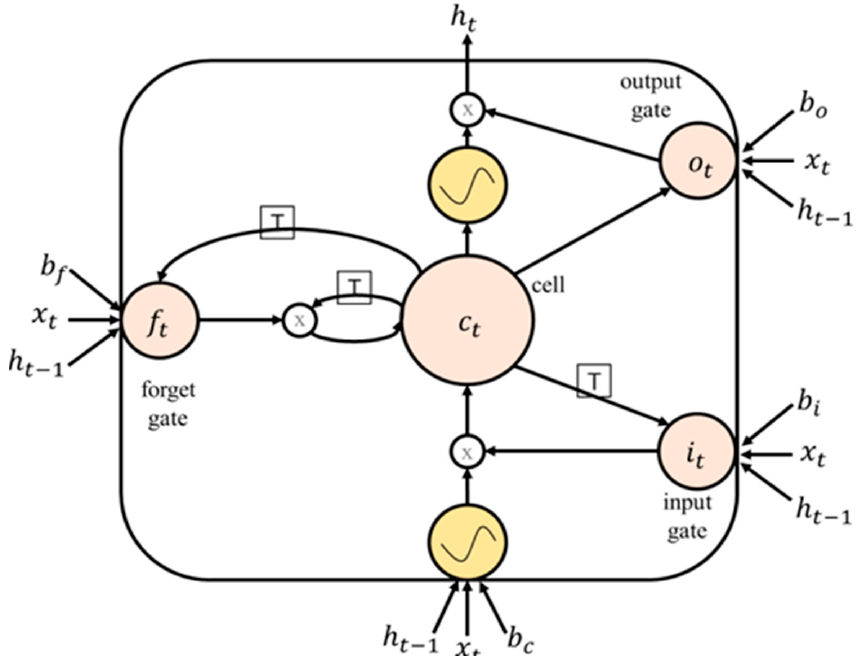
Figure 4. A basic single-cell LSTM.